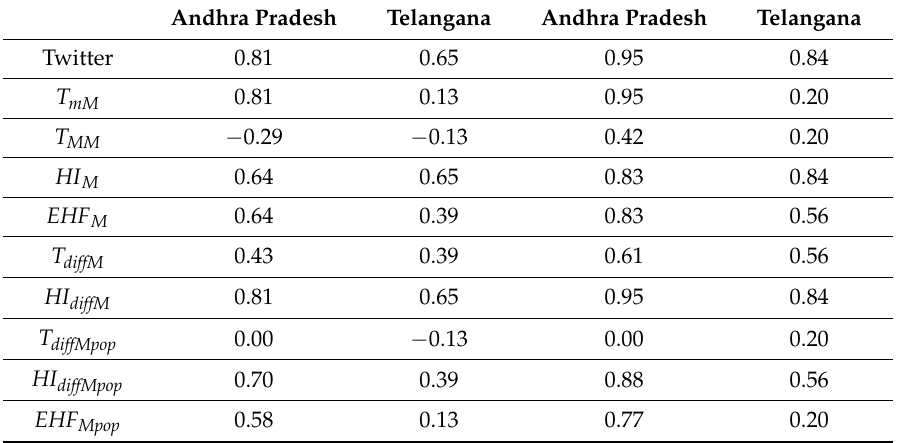
Table 7. Spearman’s ranking coefficient between IMD mortality data, Twitter and heat wave indicators, together with their significance (1 − p ) for Andhra Pradesh and Telangana. Andhra Pradesh